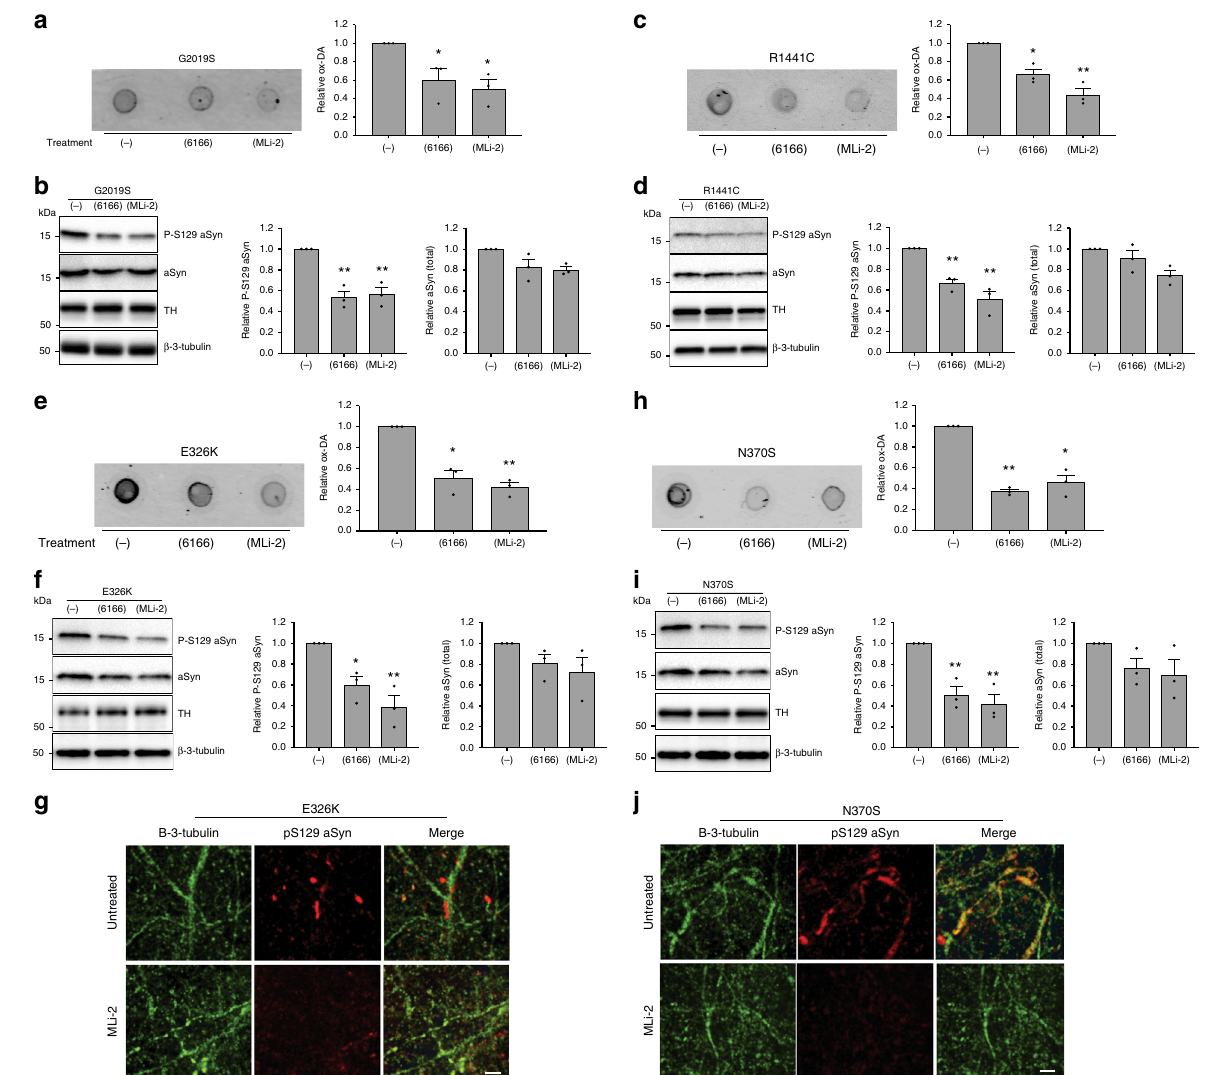
Fig. 3 LRRK2 kinase inhibitors rescue PD-related pathophysiologic phenotypes in LRRK2 and GBA1 mutant neurons. Measurement of insoluble oxidized dopamine by near-IR fl uorescence from LRRK2 G2019S. a and R1441C c mutant DA neurons treated with 6166 or MLi-2. Treated cultures were also subjected to western blot analysis of phospho-S129 aSyn (P-S129), total aSyn, and tyrosine hydrolase (TH) with β -3-tubulin used as a loading control b , d . Measurement of relative levels of insoluble oxidized dopamine by near-IR fl uorescence from DA neurons containing GBA1 E326K e or N370S h mutations. Treated cultures were also subjected to western blot analysis of P-S129, total aSyn, and TH with β -3-tubulin used as a loading control f , i . Representative images from additional DA neurons containing GBA1 E326K g or N370S j mutations treated with MLi-2 and stained with antibodies targeted to P-S129 and β -3-tubulin, scale bars, 50 µ m. The data are presented as the mean ± SEM, n = 3; * p < 0.05, ** p < 0.01 relative to untreated, one- way ANOVA followed by Tukey ’ s multiple comparison post hoc test . Source data are provided as a Source Data fi compared to vehicle-treated DA neurons, MLi-2 or 6166 treat- ment signi fi cantly reduced accumulation of dopamine oxidation products (Fig. 3a, c), as well as phospho-Ser129 alpha synuclein (Fig. 3b, d) in DA neurons with a LRRK2 G2019S or R1441C mutation. Moreover, neurons that carry a GBA1 E326K or N370S mutation also showed a signi fi cant reduction in accumulation of dopamine oxidation and phospho-S129 alpha synuclein mea- sured by western blot and immunocytochemistry in response to MLi-2 and 6166 (Fig. 3e – j). Together, these results indicate that LRRK2 kinase inhibitors or GCase modulators have the potential to protect DA neurons with LRRK2 or GBA1 mutations.